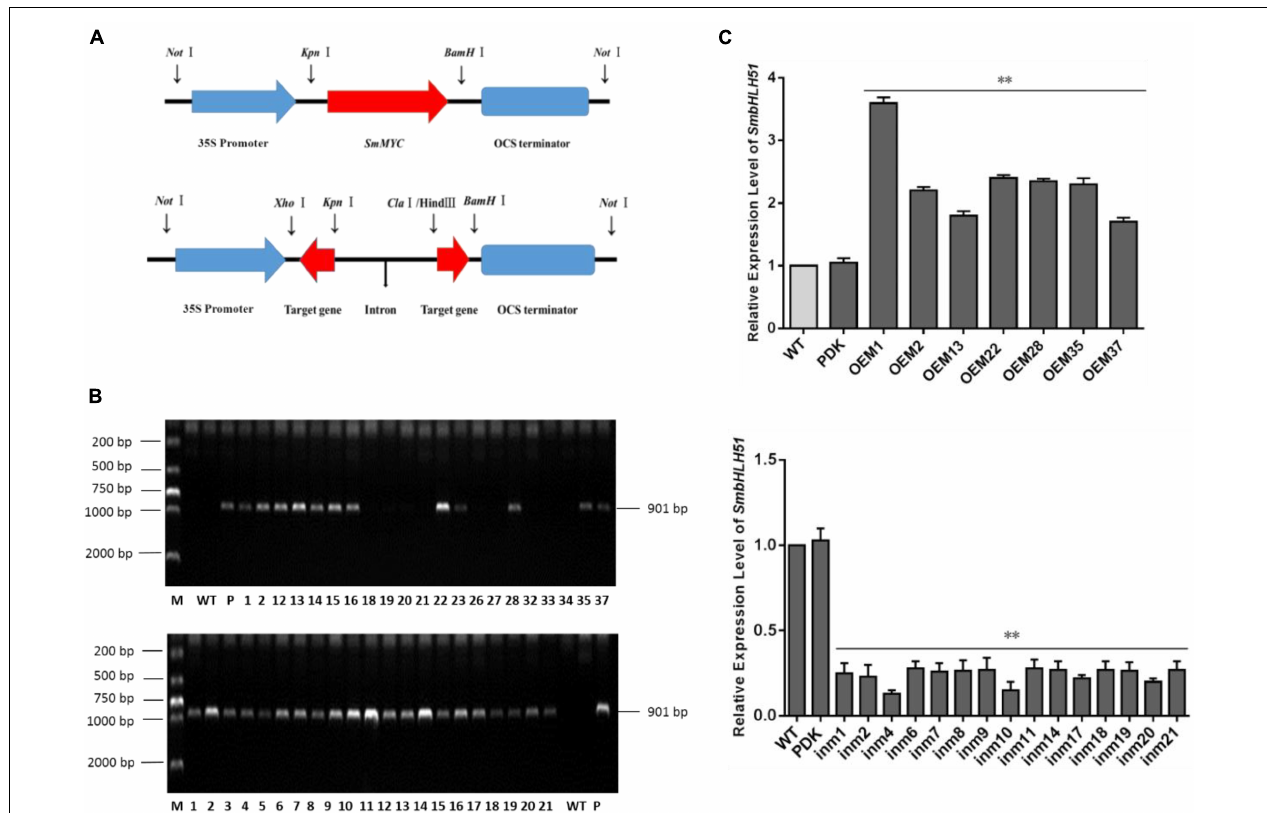
FIGURE 5 | Detection of SmbHLH51 -overexpressing and SmbHLH51-RNAi transgenic lines. (A) Sketch map of overexpression and transcription box for RNAi vectors. (B) PCR amplification product of 35S promoter from transgenic Salvia miltiorrhiza gDNA. Lanes: M, DL2000 DNA marker; P, plasmids as positive control; WT, wild-type plants as negative control. (C) Relative expression levels of SmbHLH51 in SmbHLH51 -overexpressing transgenic lines (OE) and SmbHLH51 -RNAi transgenic lines (in). The data represent means ± SD of three independent experiments. Level of SmbHLH51 in the wild type was set as 1. ∗∗ p < 0.01 compared with the wild type (Student’s t